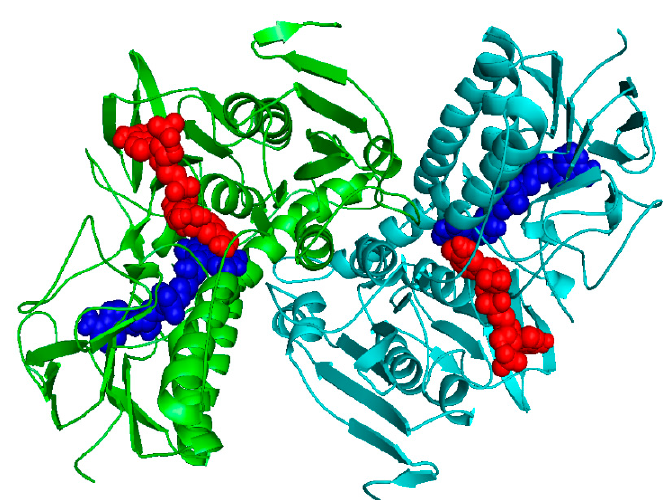
Figure 2. 3D model of the LmTR built with the SWISS-MODEL server. The two subunits are colored in green and cyan. The FAD and NADPH are indicated using blue and red spheres, respectively. The picture was generated in PyMol [22].